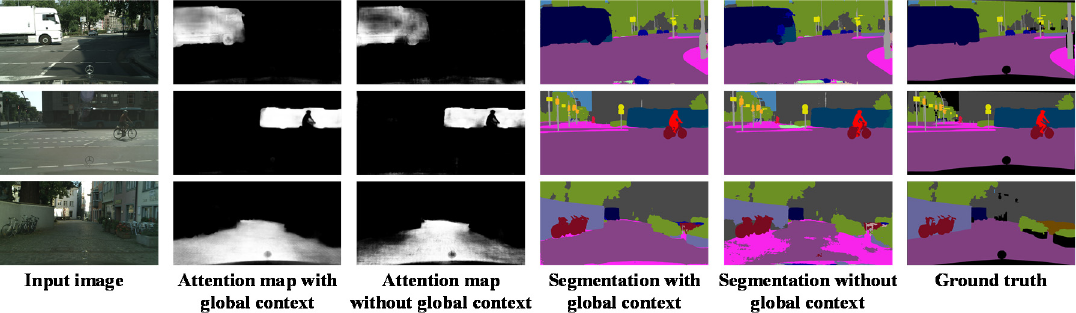
Figure 6. Visualization results of incorporating global context information versus without global context information.